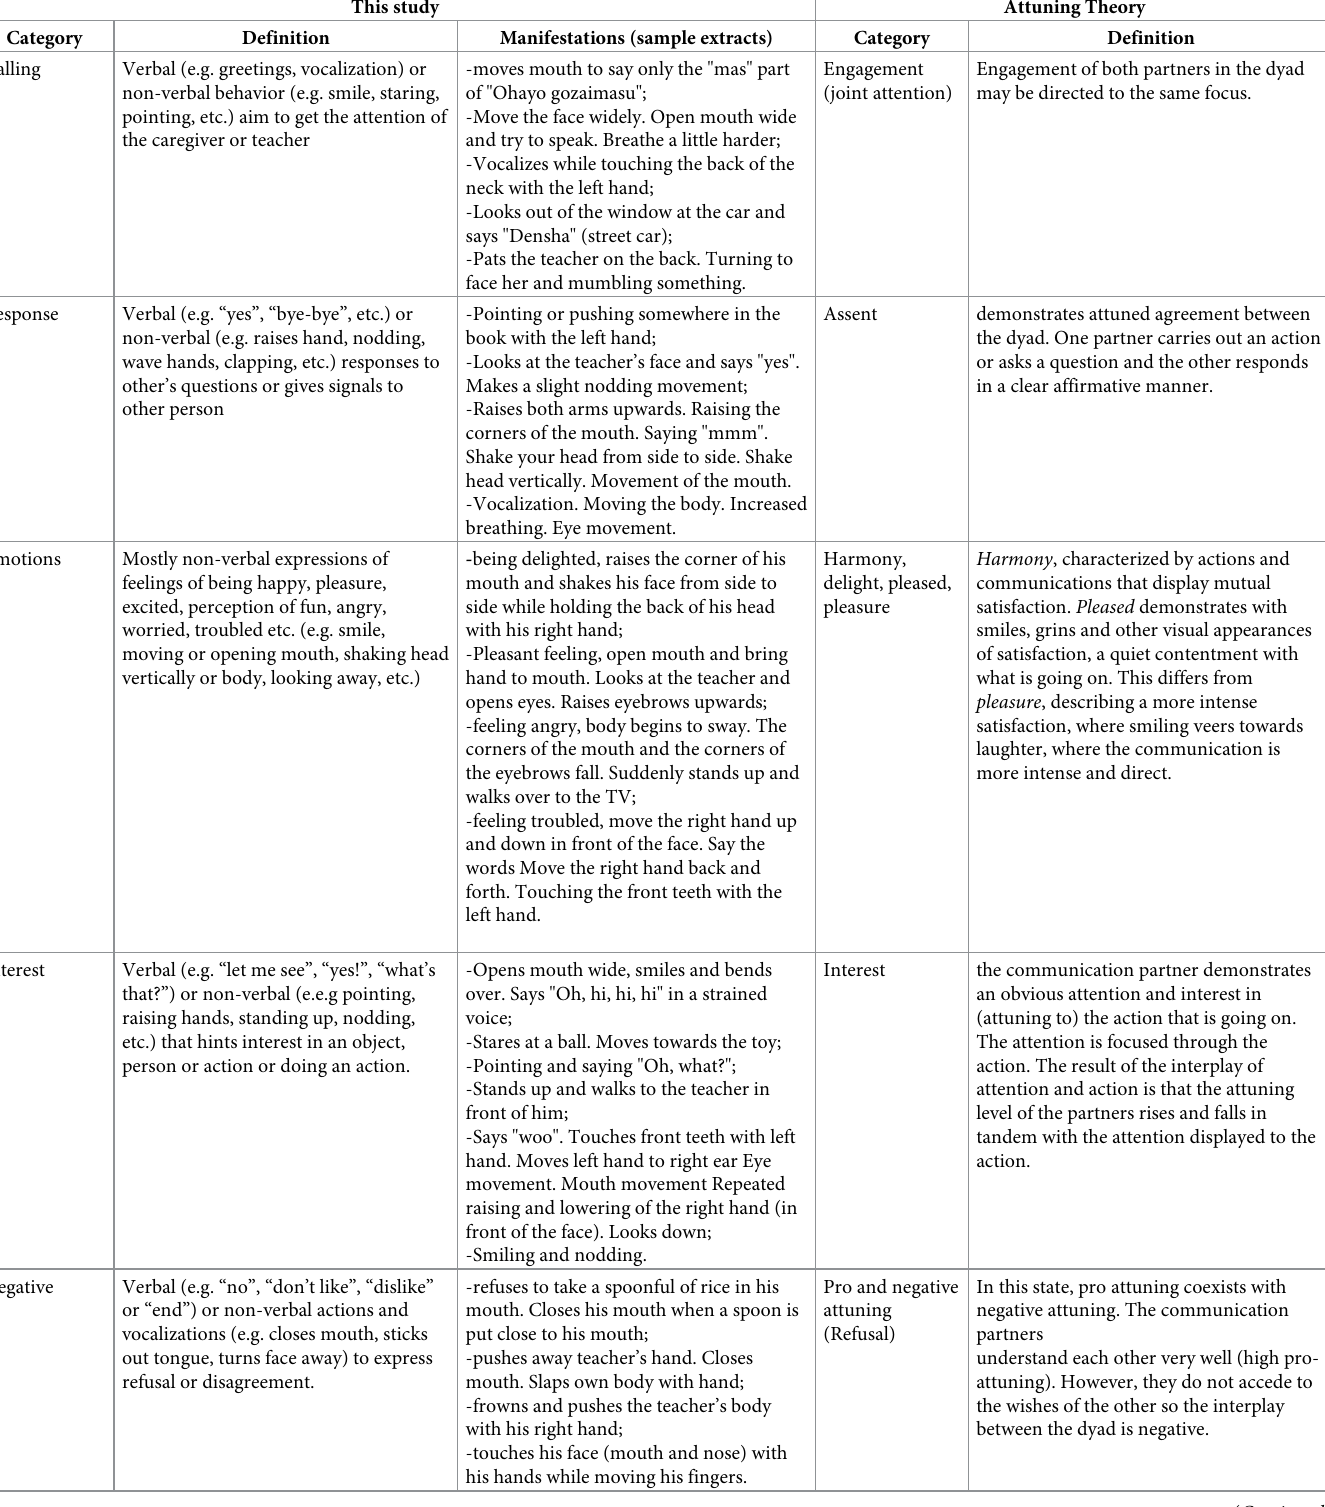
Table 1. Movement definitions and manifestations of the 7 behavior outcome classes in comparison with the Attuning